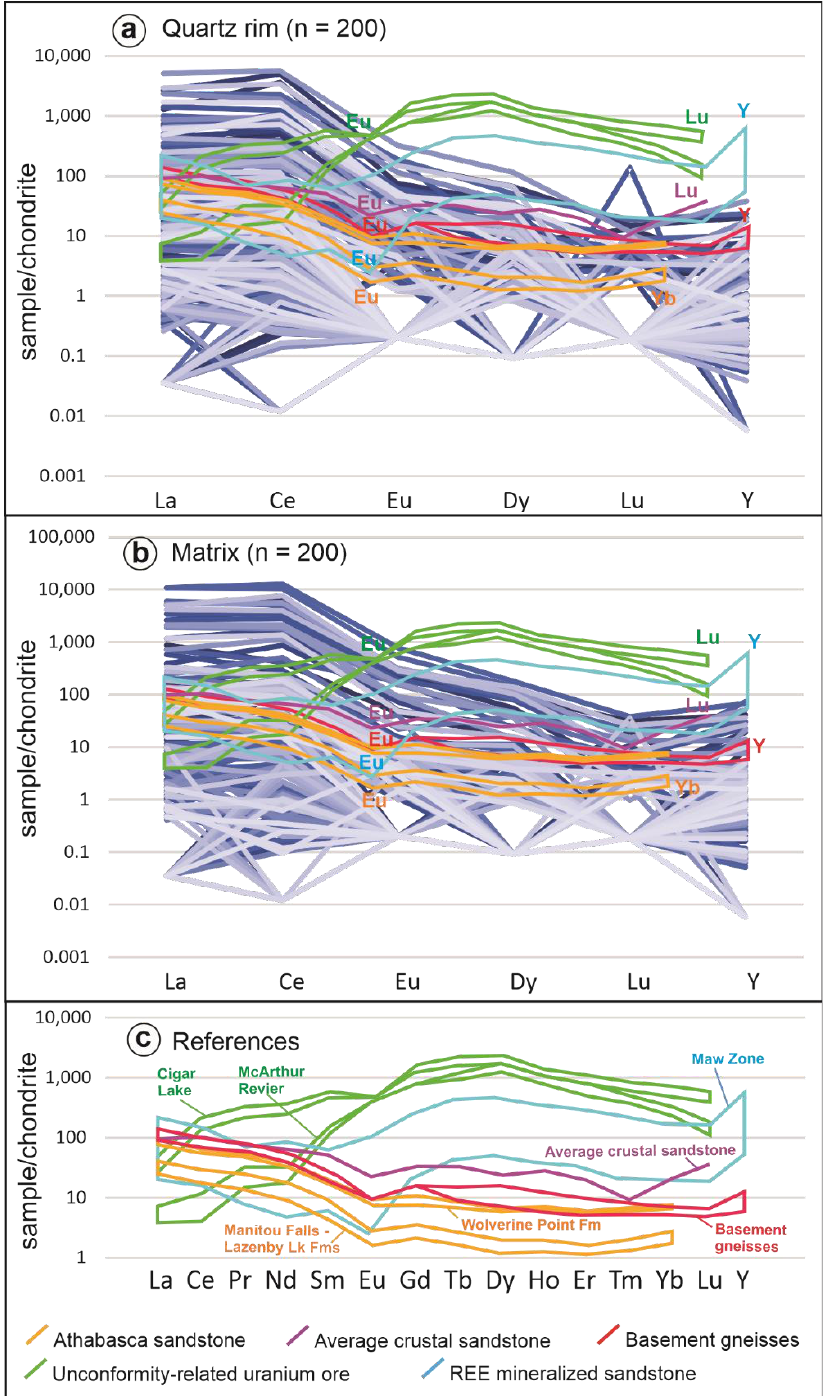
Figure 8. Chondrite-normalized REE patterns (chondrite values from [46]) of quartz rim ( a ) and matrix ( b ), each with 200 spots, and reference materials ( c ) including Athabasca sandstone [29], average crustal sandstone [47], basement gneisses [5], uraninite in unconformity-related U ores (Mercadier et al., 2011a) and REE (Y) mineralized sandstone at Maw Zone [43]. The analytical results in ( a , b ) are shown by the thick blue-purple lines with variable degrees of lightness to maximize the visibility of individual analyses. The REE patterns of the references are superimposed on the analytical results of this study ( a , b ) for direct comparison; note, however, that the REE patterns of the references (15 elements) are distorted to fit into the framework of the analyses of this study (only 6 elements).